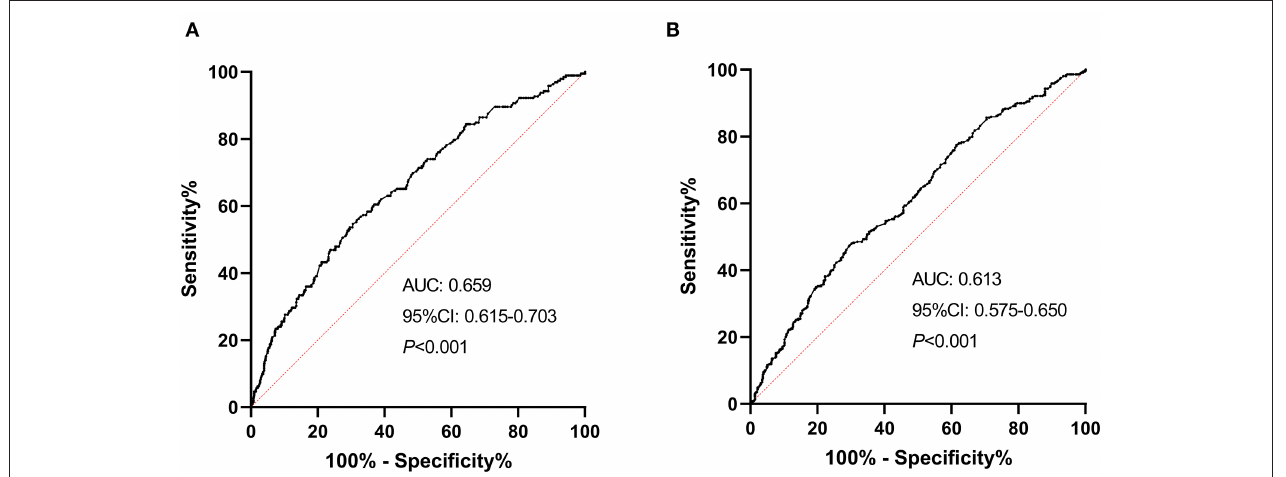
FIGURE 4 | ROC curves for the initial stroke severity and short-term prognosis of sICAS with NLR. (A) ROC curve for the initial stroke severity of sICAS with NLR (severe stroke vs. mild controls). (B) ROC curve for the short-term prognosis of sICAS with NLR (unfavorable outcome vs. favorable outcome). ROC, receiver operating characteristic; sICAS, symptomatic intracranial atherosclerotic stenosis; AUC, area under the curve; NLR, neutrophil-to-lymphocyte ratio; CI, confidence